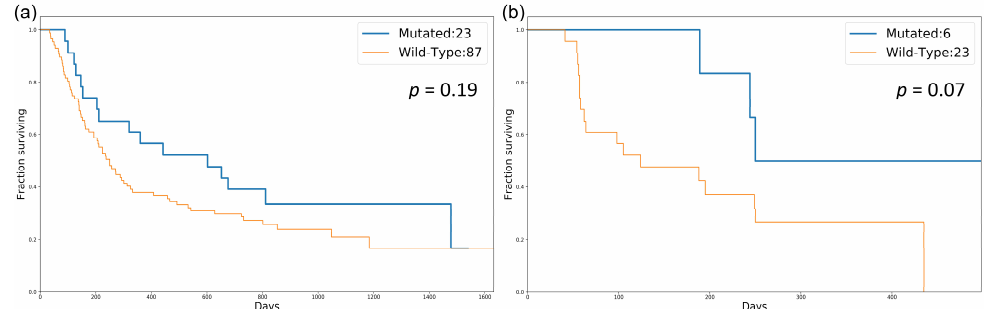
Figure 4. Survival analysis for patients in the mutated and wild-type groups in SKCM and LUAD: ( a ) comparison of OS in SKCM; ( b ) comparison of PFS in LUAD. p -value was calculated by the log-rank test.